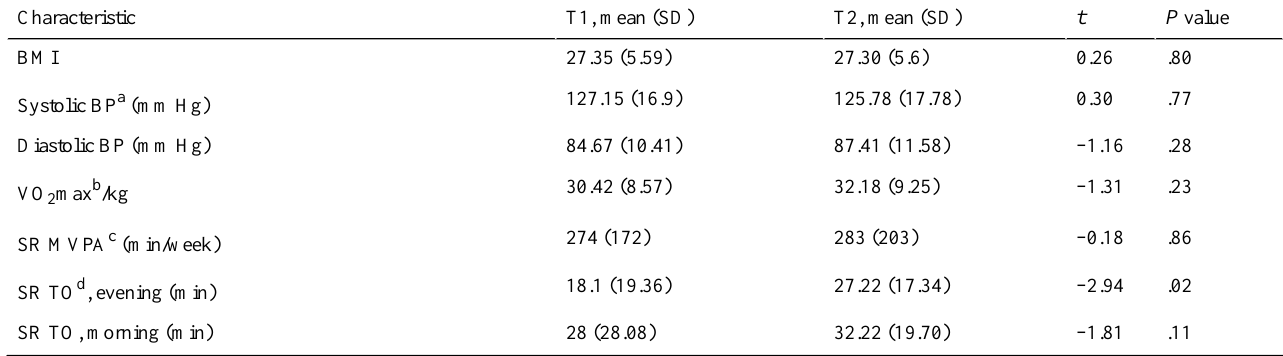
Table 2. Pre-post measurements in the sleep silent